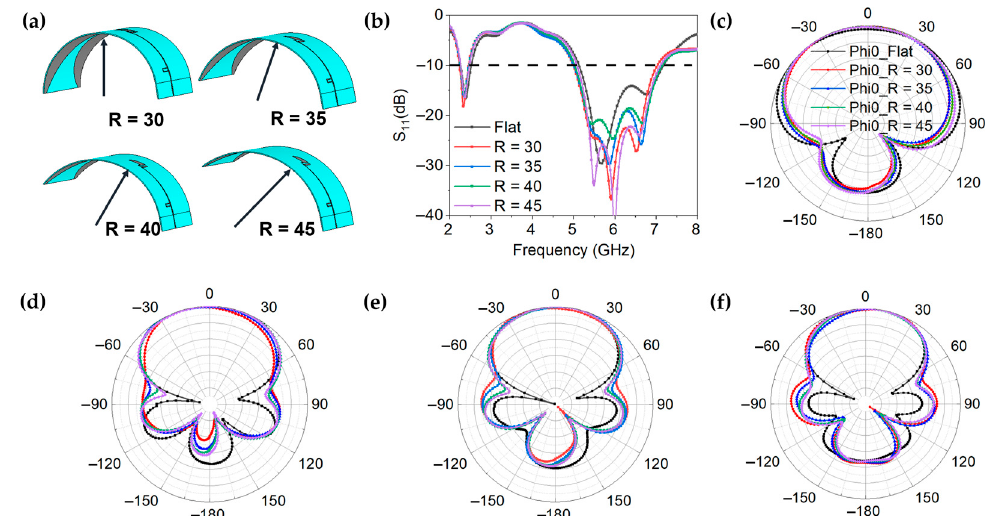
Figure 3. ( a ) Proposed GAF antenna under different bending angles. ( b ) Simulated reflection coefficients of the GAF antenna under different bending states. ( c – f ). Simulated radiation patterns of the GAF antenna under different bending radii at different frequencies of ( c ) 2.45 GHz. ( d ) 5.5 GHz. ( e ) 6.0 GHz. ( f ) 6.5